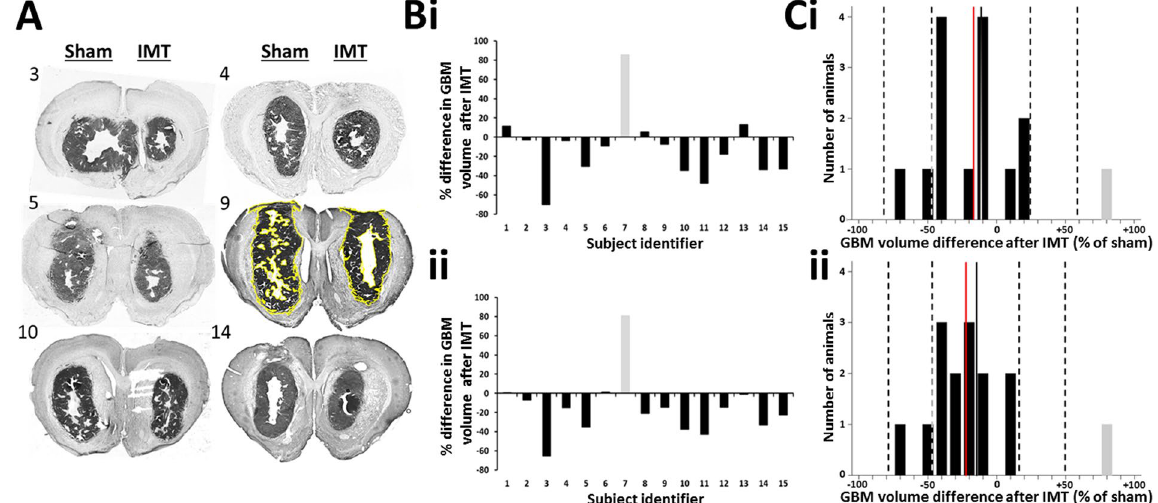
Figure 4. IMT attenuates locoregional GBM growth in vivo . ( A ) Representative, thionine-stained brain sections from 6 animals with GBM treated throughout this study. The 7-day course of IMT was randomized to the right or left GBM (treatment sides have been aligned in this figure for comparative purposes), with the contralateral tumor used as a sham control. The subject identifier is shown to the upper left of each section. GBM volumes were estimated by cumulative cross-sectional tumor areas quantified using ImageJ software, as demonstrated by the yellow tracing in subject 9. ( B ) The difference in estimated whole (i) and core (ii) GBM volume following IMT, relative to the internal sham control, is provided for every animal. Negative values are consistent with treatment response. The whole tumor measures incorporate serial sections through the rostrocaudal extent of the GBM whereas the core tumor measures were limited to the region surrounding the bioelectrode. There was one outlier (#7, shown in gray) with a reversal of expected effects, presumed technical in origin. ( C ) Distribution plots showing volume differences in the IMT-treated i) whole and ii) core tumor over 10% intervals. For example, a data bar on the − 50% tick mark depicts the number of animals that had a 50–60% tumor reduction. The solid black-to-white lines indicate the cohort means when the data included the outlier shown in gray. The dashed lines indicate the standard deviation of this mean. Note that the outlier is well beyond 2 standard deviations of the mean. The red lines depict the cohort means with the outlier